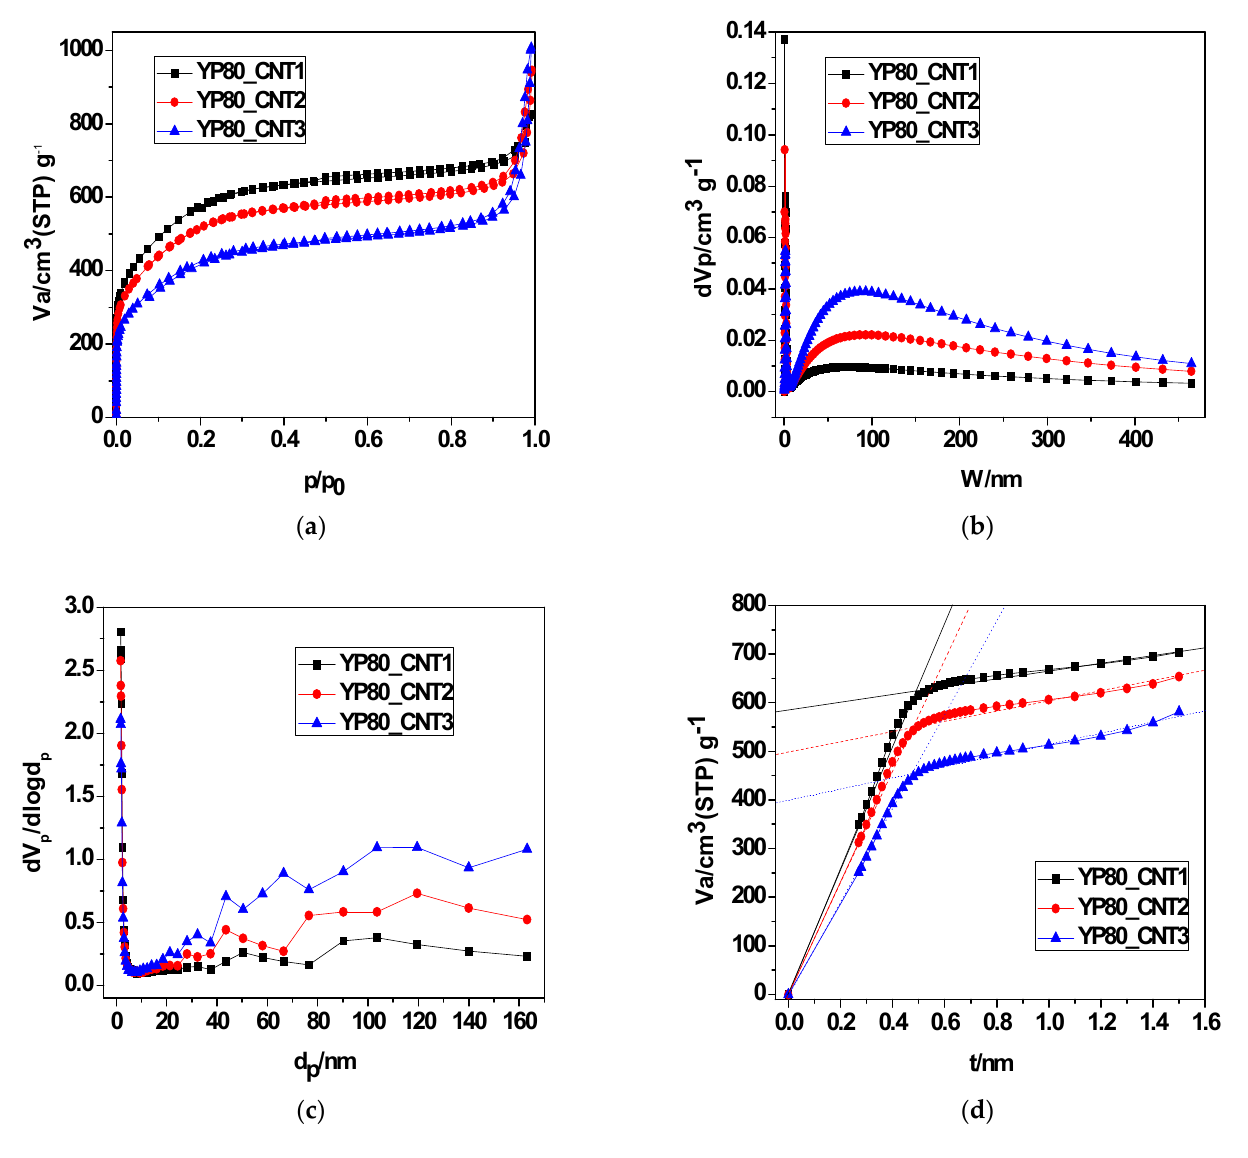
Figure 4. Surface properties of the electrode after the electrode reaction; ( a ) adsorption–desoprtion isotherm, ( b ) pore size distribution, ( c ) t-plot, and ( d ) BJH plot.